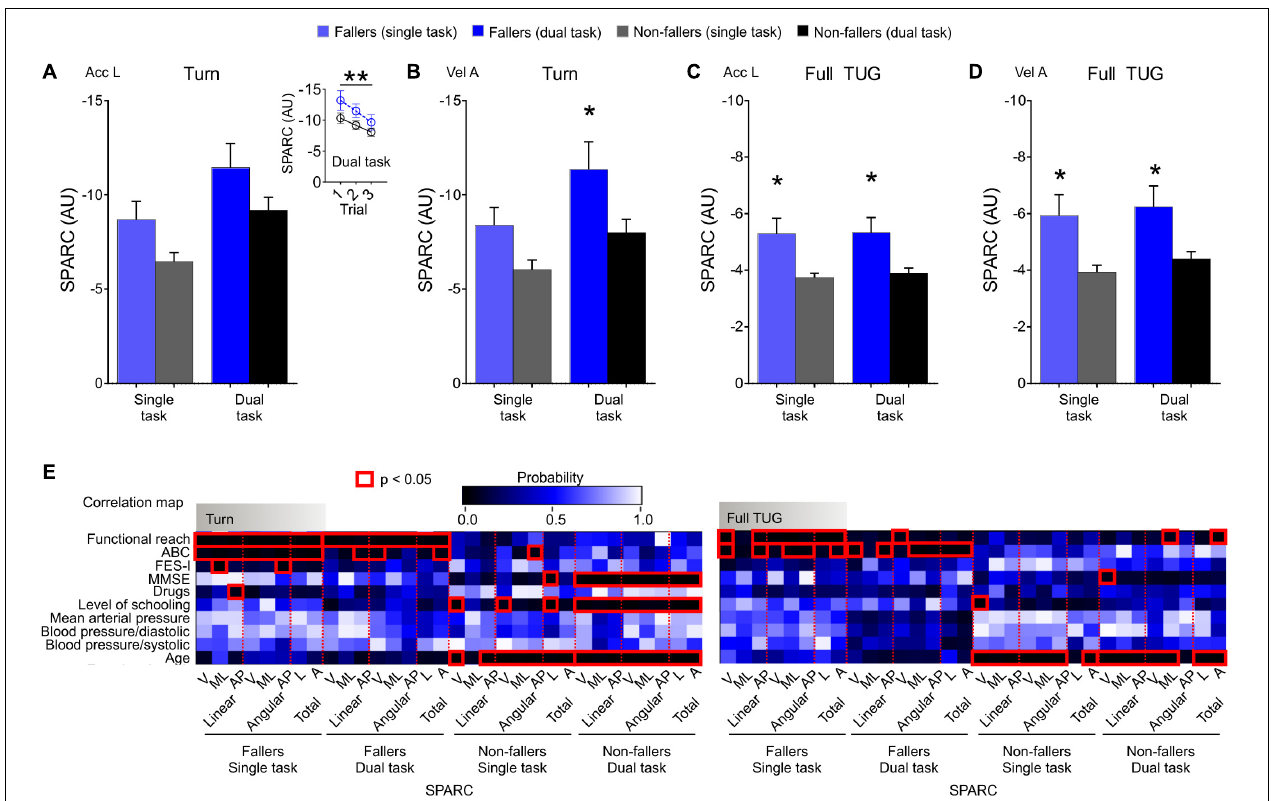
FIGURE 3 | Turning displayed drastically reduced smoothness (SPARC) values for oldest-old fallers and non-fallers. (A) The turning phase of the TUG test showed reduced smoothness (SPARC Acc L) mostly in the first trial, but increased movement smoothness was evident between trials (inset). The between-trial collapsed data showed the absence of group effects. (B) The SPARC angular component (SPARC Vel A) during turning, on the other hand, displayed group effects and a post hoc effect for the dual task. (C,D) During the full TUG, the SPARC was reduced for fallers performing single or dual tasks. (E) Similar to the walking bouts, SPARC metrics during turning consistently correlated with the functional reach test and ABC scale for fallers. Non-fallers also showed correlations with MMSE, level of schooling, and age. Note that when the full TUG is considered, non-fallers showed fewer correlations with the MMSE and level of schooling. Two-way repeated-measures ANOVA with factors time (single X dual task) and group (fallers X non-fallers) followed by Sidak correction ( post hoc ). Data are mean ± SEM; n Fallers = 32; n Non − fallers = 32; * p < 0.05 ( post hoc ); ** p < 0.05 trial effect in the ordinary ANOVA (group Fallers X Non-fallers; trial 1 × 2 × 3; task Single X Dual); red rectangles in E are * p < 0.05 (Spearman correlation). V: ventral; ML: mediolateral; AP: anteroposterior; SPARC: spectral arc length; Acc L: linear acceleration; Vel